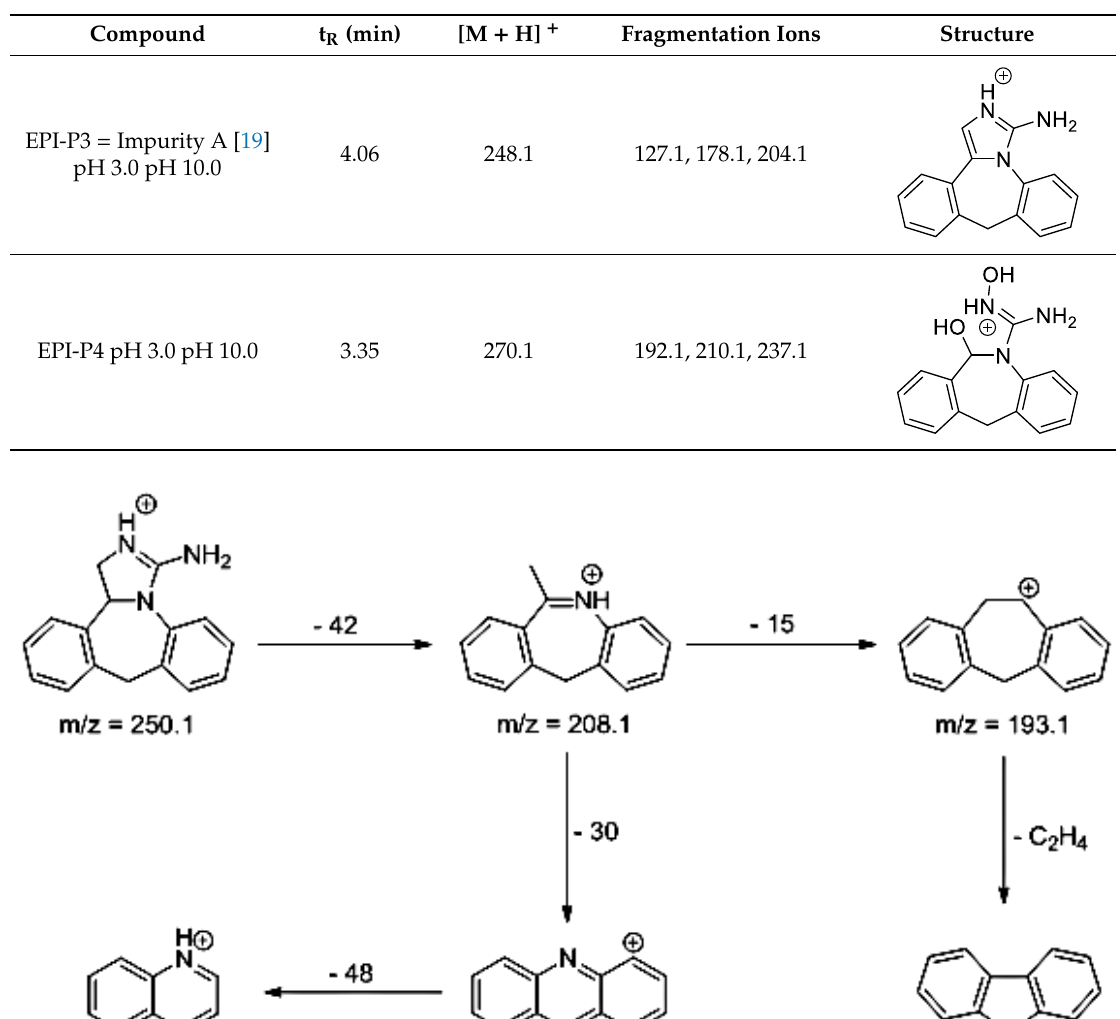
Figure 7. Proposed fragmentation pattern of epinastine (EPI).